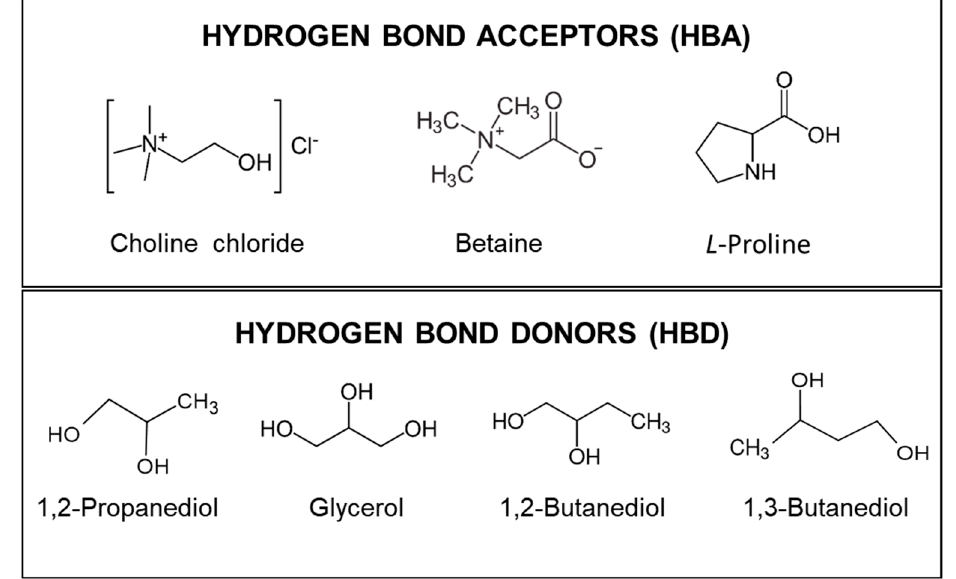
Figure 7. Chemical structures of the components of NAESs (HBAs and HBDs).